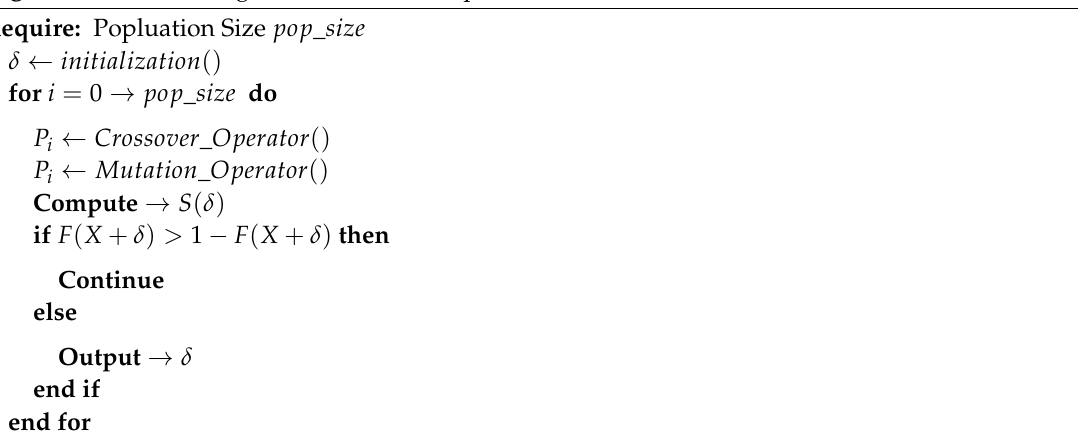
Algorithm 1 Generating an adversarial